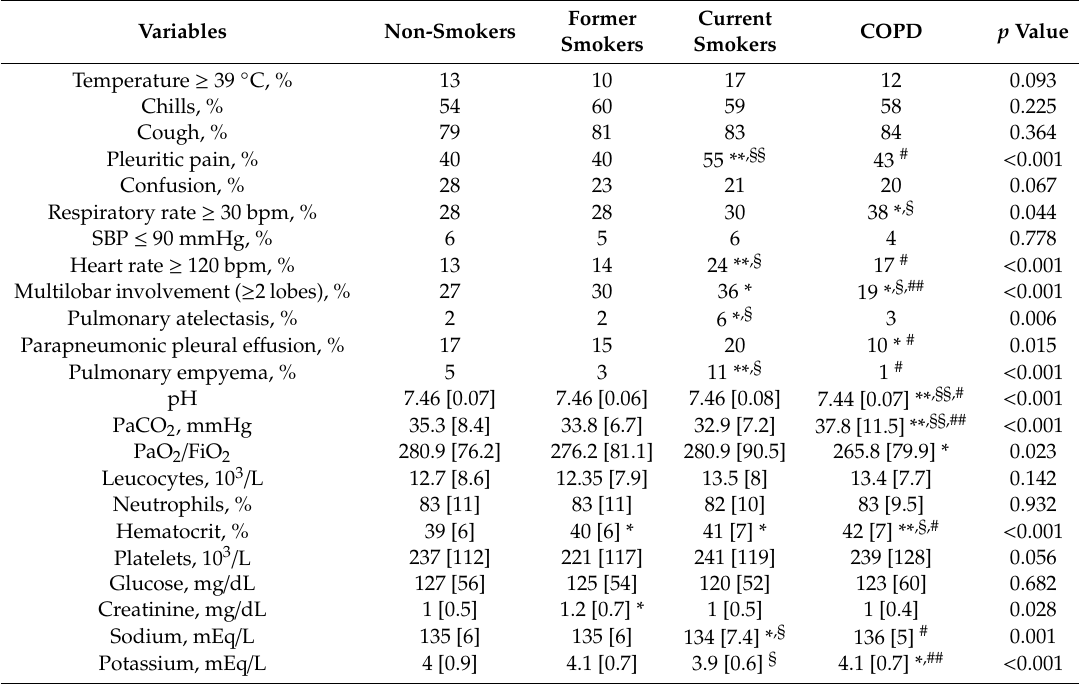
Table 2. Clinical and laboratory variables by smoking habit and COPD diagnosis.